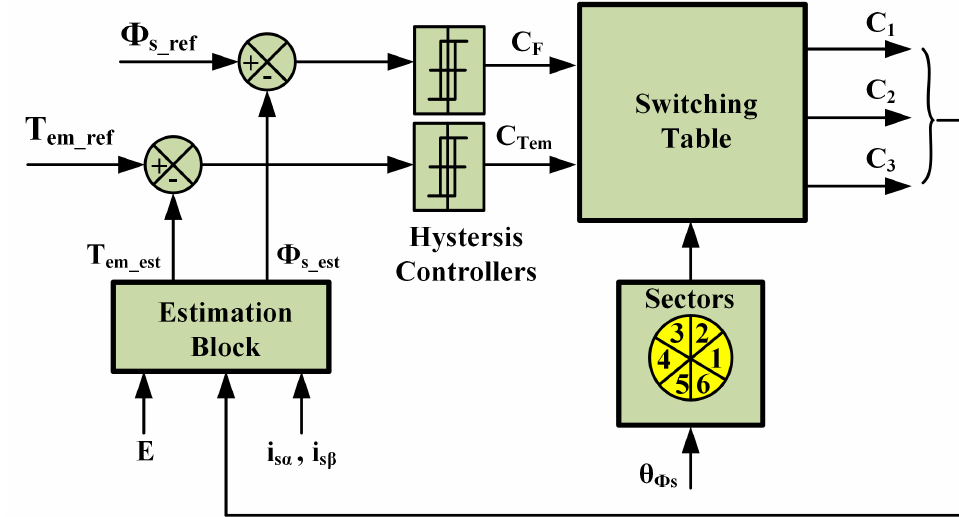
Figure 1. The block diagram of the classical DTC.